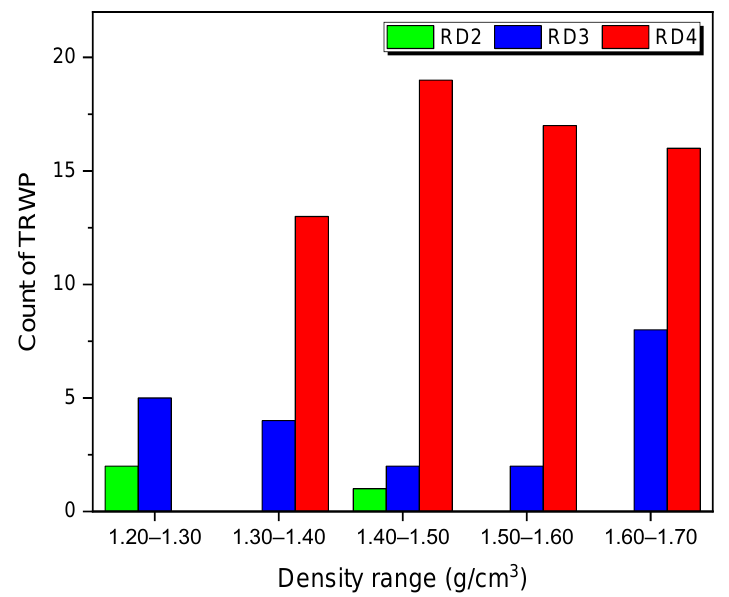
Figure 6. Variations in the numbers of TRWPs in the road dust samples with the TRWP density.